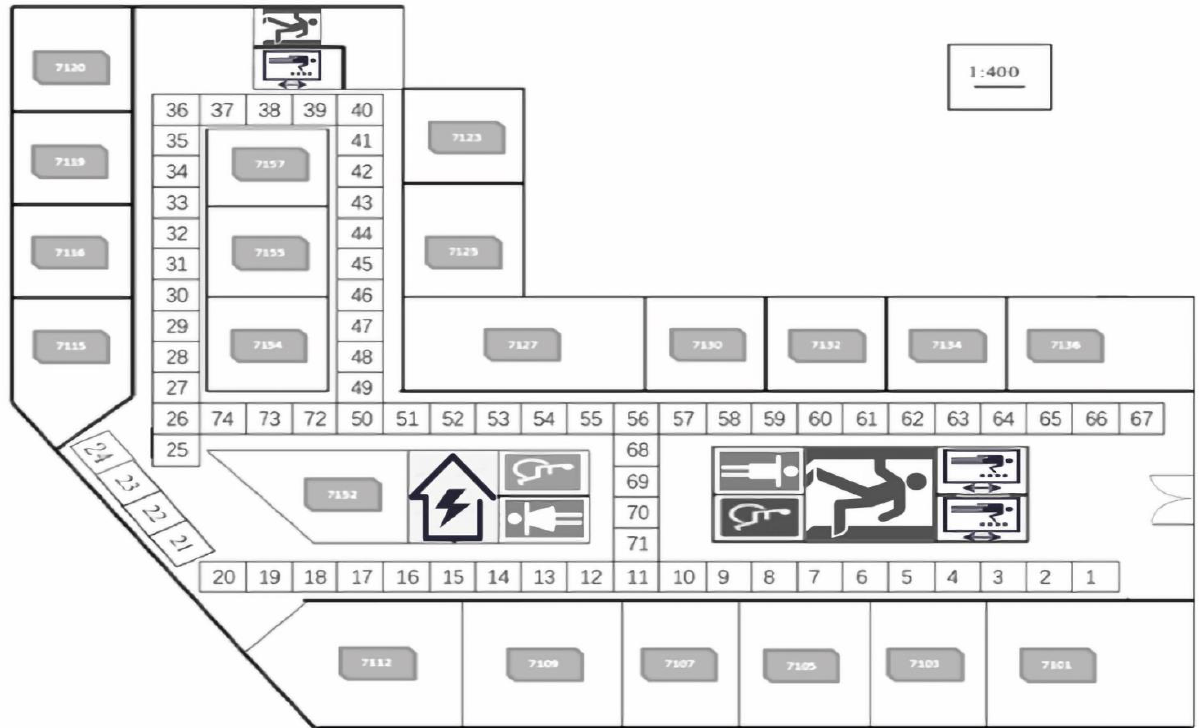
Figure 2. Environment setup for a floor map with 74 reference points.